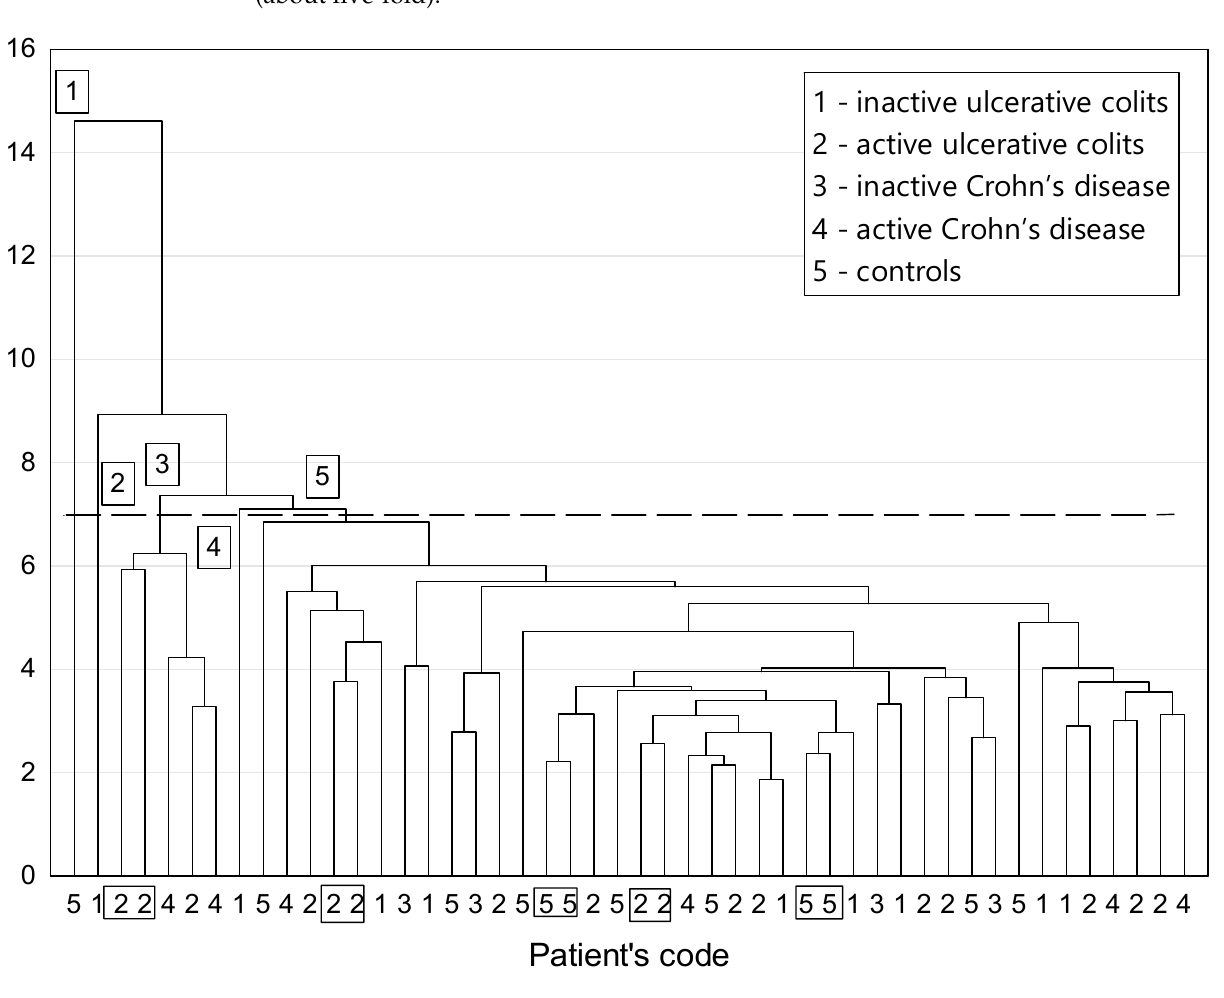
Figure 2. A dendrogram of similarity among study participants (method of grouping: average linkage procedure; function of the distance: Euclidean distance; the dashed horizontal line indicates that grouping was stopped according to the Mojena’s rate); patients were labeled according to the classification code; the determined clusters of patients were labeled with numbers: 1–5; rectangles encompass patients belonging to two-element clusters.